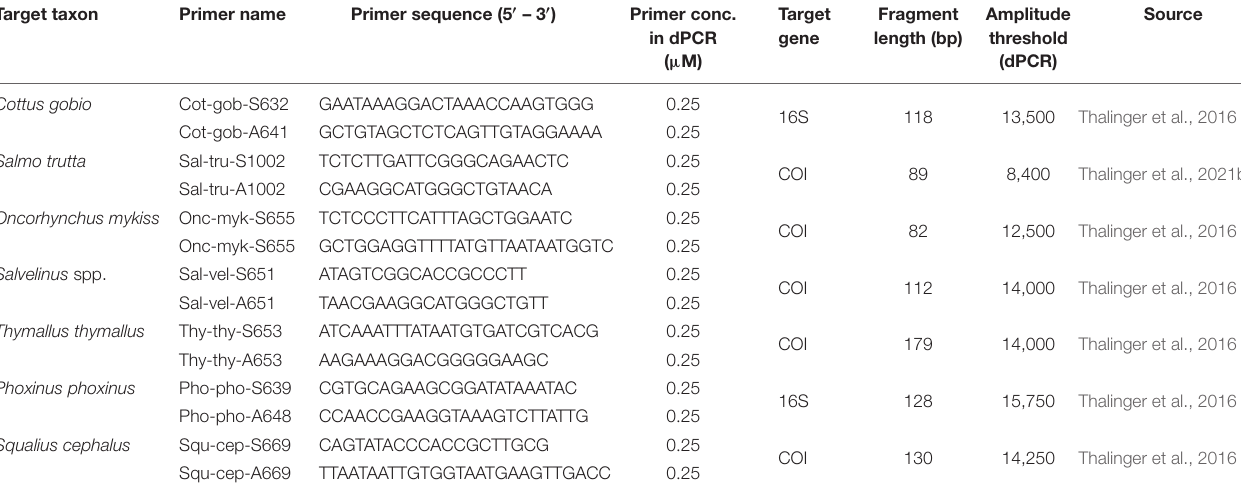
TABLE 1 | Digital PCR assays used to amplify fish eDNA.